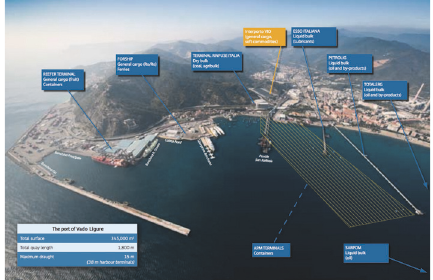
Figure 2: Port of Vado Ligure, 2010 (Savona Port Authority, 2010)